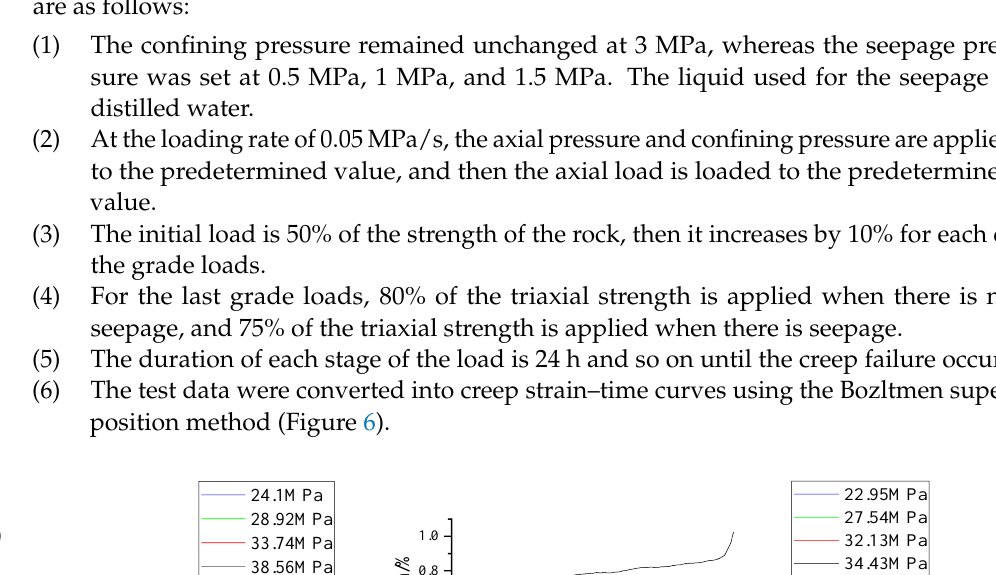
Figure 5. Failure modes under different seepage pressures.